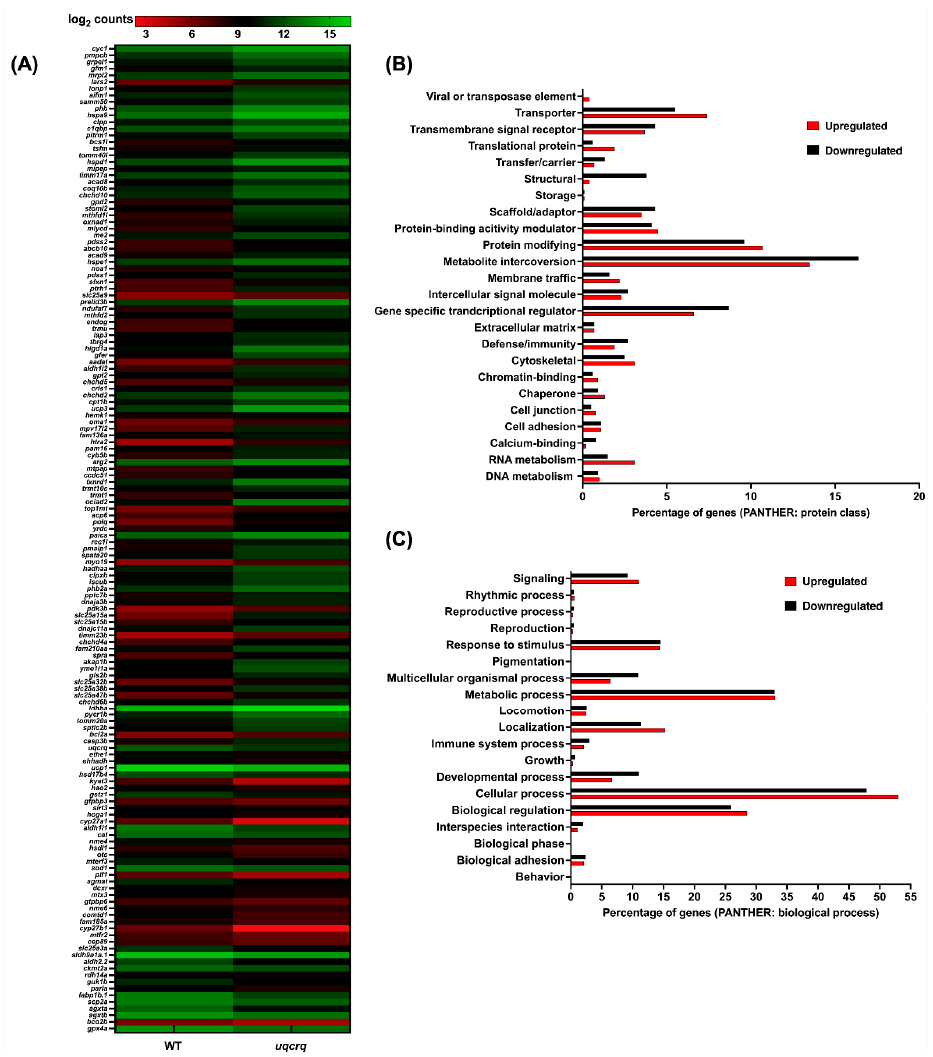
Figure 5. RNAseq analysis of uqcrq mutants: ( A ): Differential expression of zebrafish orthologs for human mitochondrial resident proteins; MitoCarta is represented as a heat map. The gradient color scale represents the log 2 CPM value obtained for each of the zebrafish mitochondrial orthologs in the two datasets. ( B – C ): Differentially expressed genes classified according to protein class ( B ) and ( C ) biological processes. Each histogram represents the percentage of genes falling in each of the categories.